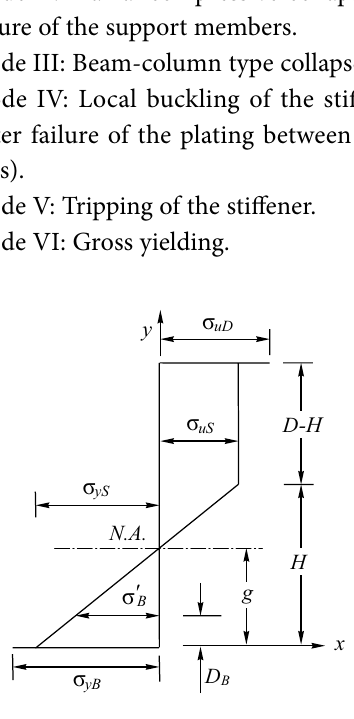
Fig. 3. Longitudinal stress distribution over the box cross- section in the overall collapse state suggested by Paik and Mansour